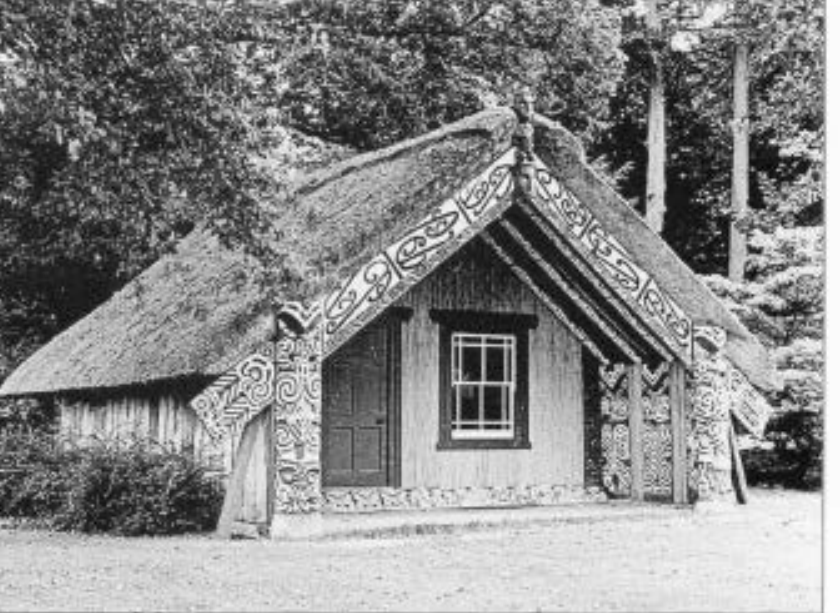
Figure 6 Hinemihi at Clan don Park following restoration in